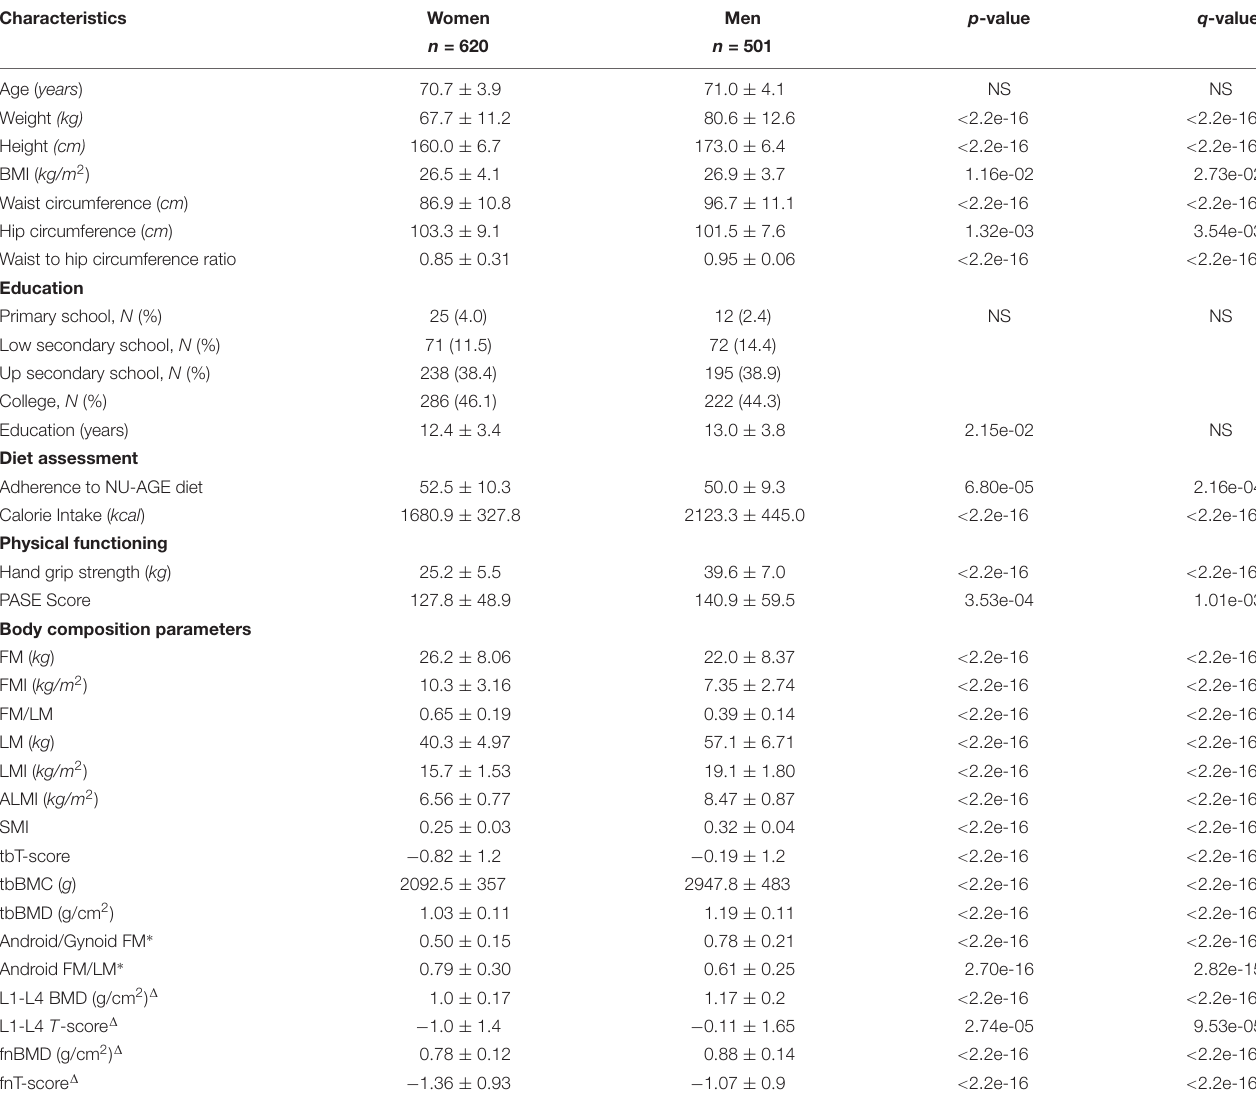
TABLE 1 | Characteristics of the NU-AGE participants ( N = 1,121) by sex.